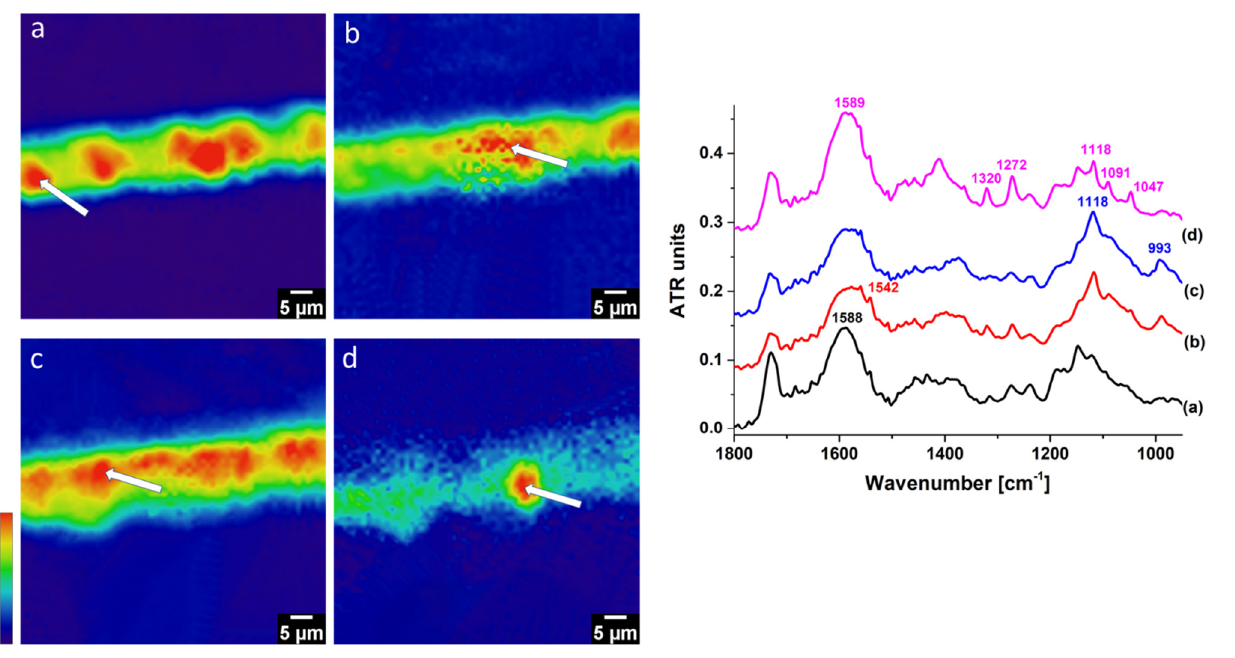
Figure 2. ATR–FTIR FPA imaging from the centre spot (70 × 70 µm 2 ) and representative spectra: ( a ) amorphous zinc soap (1590 cm -1 ), ( b ) crystalline zinc soap (1540 cm -1 ), ( c ) gordaite (1120 cm -1 ), and ( d ) zinc lactate (1270 cm -1 ). Red denotes the highest intensity, and blue denotes the lowest intensity. For clarity of presentation, the experimental artefacts from the areas outside the sample were removed. ATR–FTIR spectra were taken from the spot with the highest intensity within the imaging representative for a selected wavenumber (marked by the white arrows).